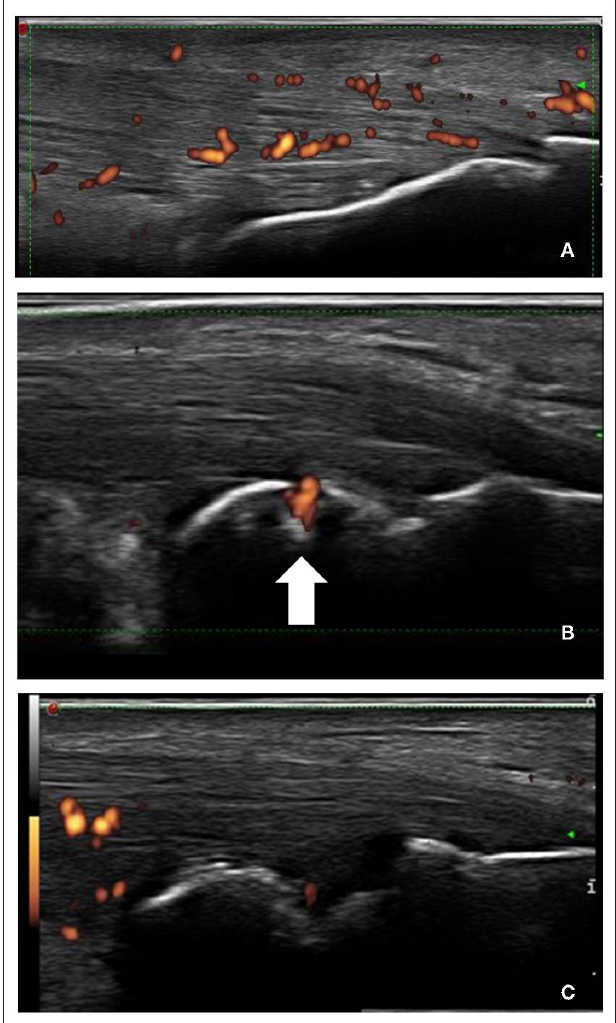
FIGURE 1 | Longitudinal scans of Achilles tendon in SpA. (A) Increased thickness of tendon insertion, enthesophyte (the step up of the bony prominence at the end of the normal bone contour), and power Doppler signal. (B) The arrow shows PD signal inside bone erosion and (C) arrowhead shows retrocalcaneal